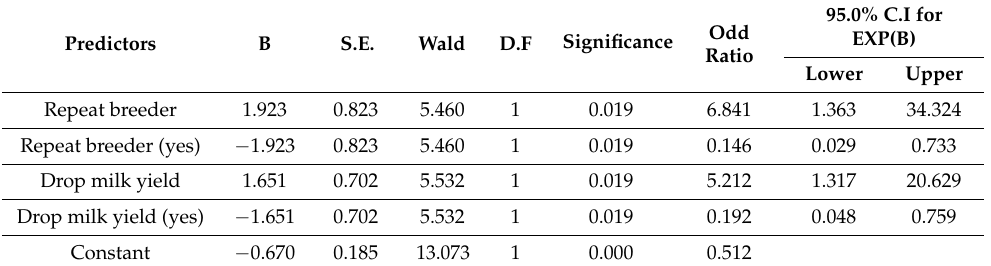
Table 6. Multivariate analysis of risk factors associated to Leptospira spp. infection in cattle.